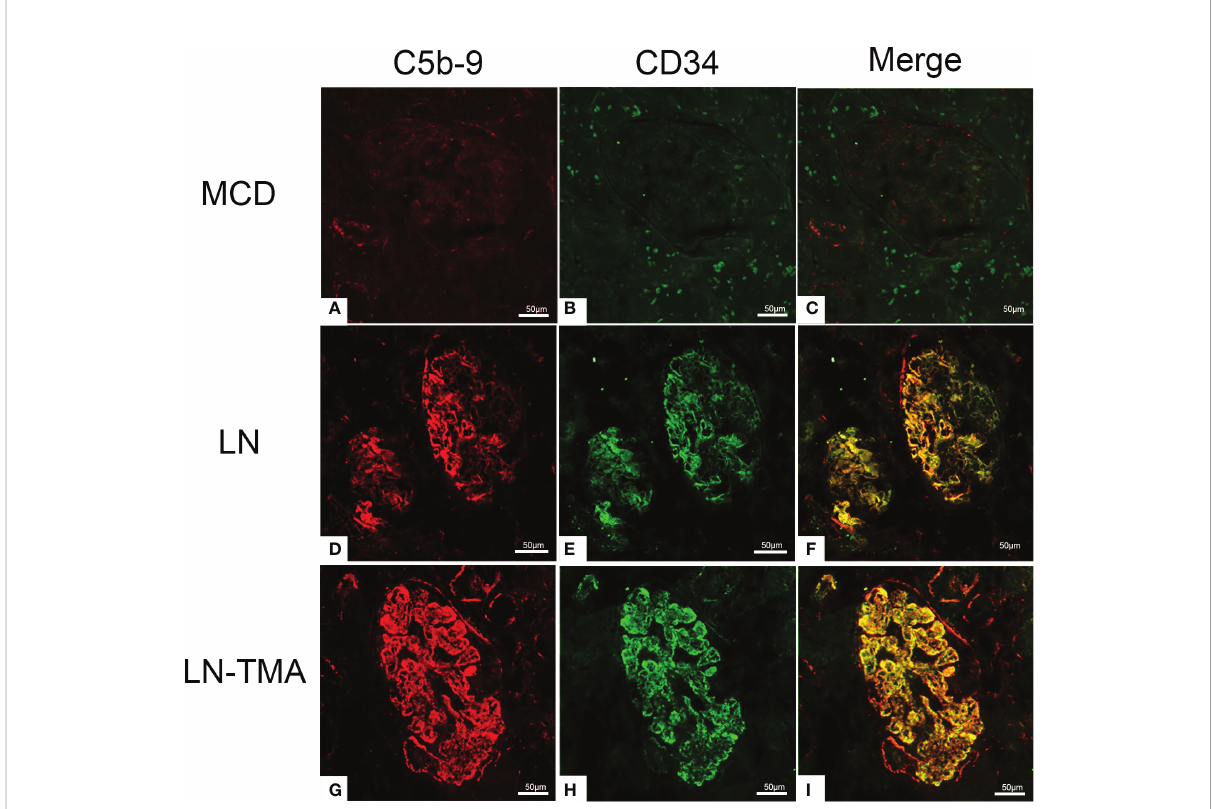
FIGURE 7 Frozen sections for C5b-9, CD34, and co-localization using immuno fl uorescence among MCD (A-C) , LN (D-F) , and TMA (G-I) patients. (A-C) Deposition of C5b-9 (red), CD34 (green), and co-localization (yellow) in MCD was negative. (D-F) Deposition of C5b-9 (red), CD34 (green), and co-localization (yellow) along the glomerular capillary and arteriole in LN was moderate staining. (G-I) Deposition of C5b-9 (red), CD34 (green), and co-localization (yellow) along the glomerular capillary and arteriole in TMA was strong staining. Scale bars represent 50 m m.